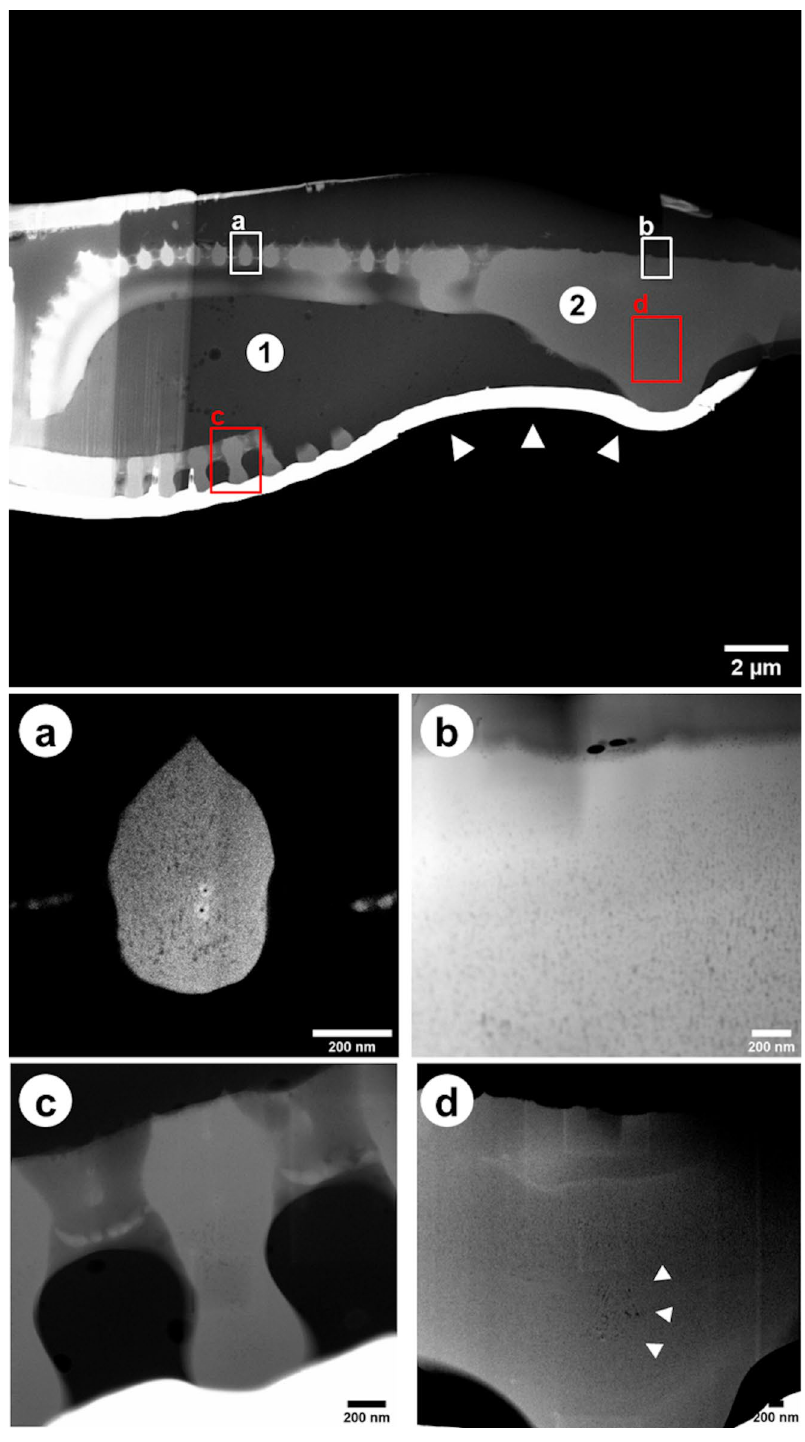
Figure 7. TEM dark field images. Cross-section of Didymosphenia geminata frustule: (1) epoxy filling, (2) frustule, white arrowheads: Pt protection layer; ( a ) single rib with increased contrast to visualize the pores; ( b ) central area with dense layer on outside; ( c ) other rib shows also uneven distribution of pores; ( d ) central area close to stigma with some bigger pores (white